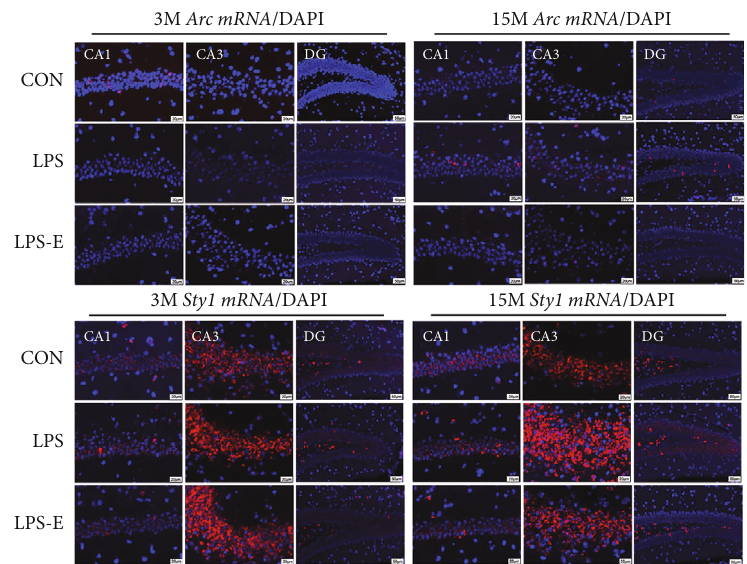
Figure 5: Representative photomicrographs of Arc and Syt1 mRNA levels in di ff erent hippocampal subregions in CD-1 mice at di ff erent ages and under di ff erent treatments. Scale bar = 20 μ m in the CA1 and CA3, 50 μ m in the DG. CA: cornu ammonis; DG: dentate